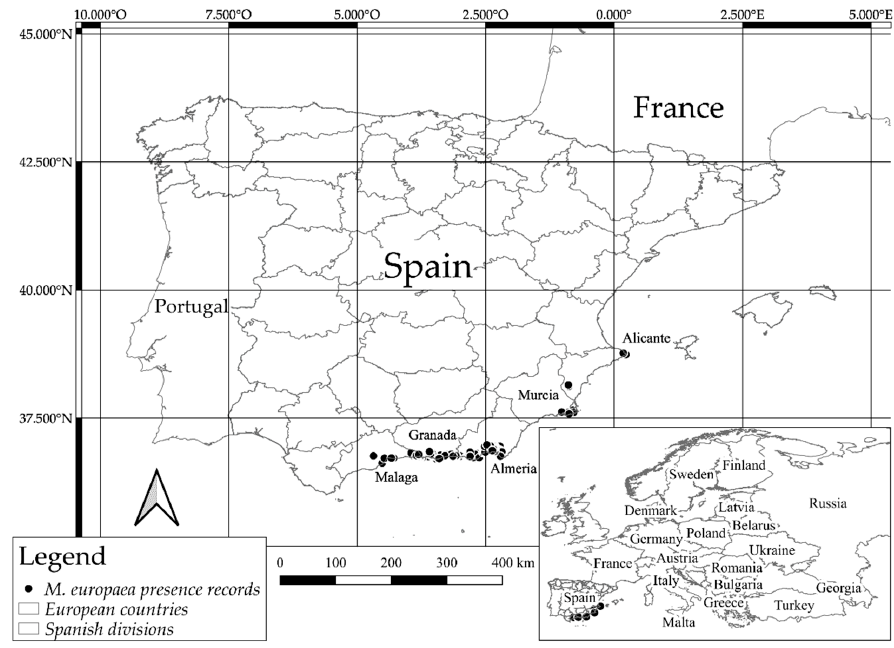
Figure 1. Presence records of M. europaea in Europe. The localities are represented by dots and de ‐ tailed in Table S1. detailed in Table